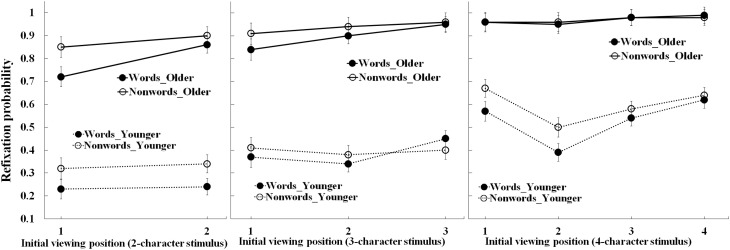
Refixation probability for the older and young adults as a function of the initial viewing position and stimulus type. Bars correspond to standard errors.